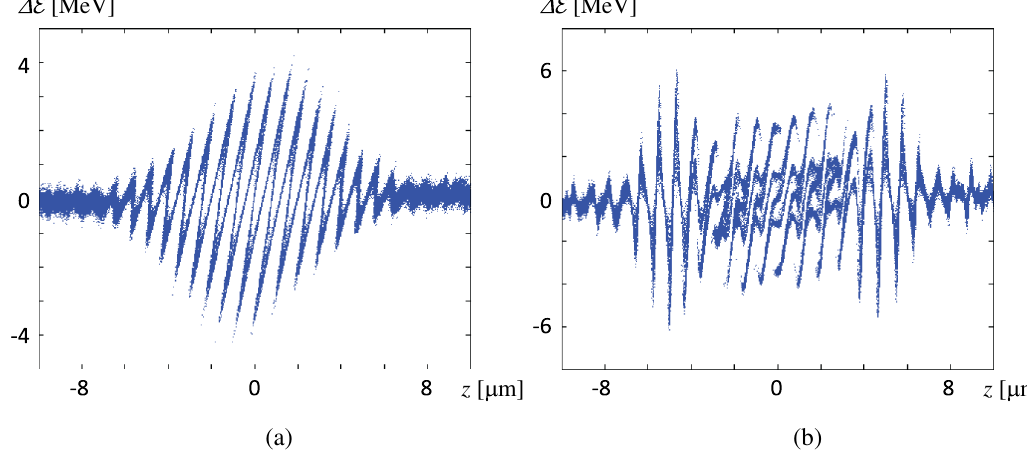
FIG. 9. Application A: longitudinal phase space (a) direct after chicane 3 and (b) 15 m behind, for 30 fs (FWHM) laser modulation, calculated with one million macro-particles, by Astra.